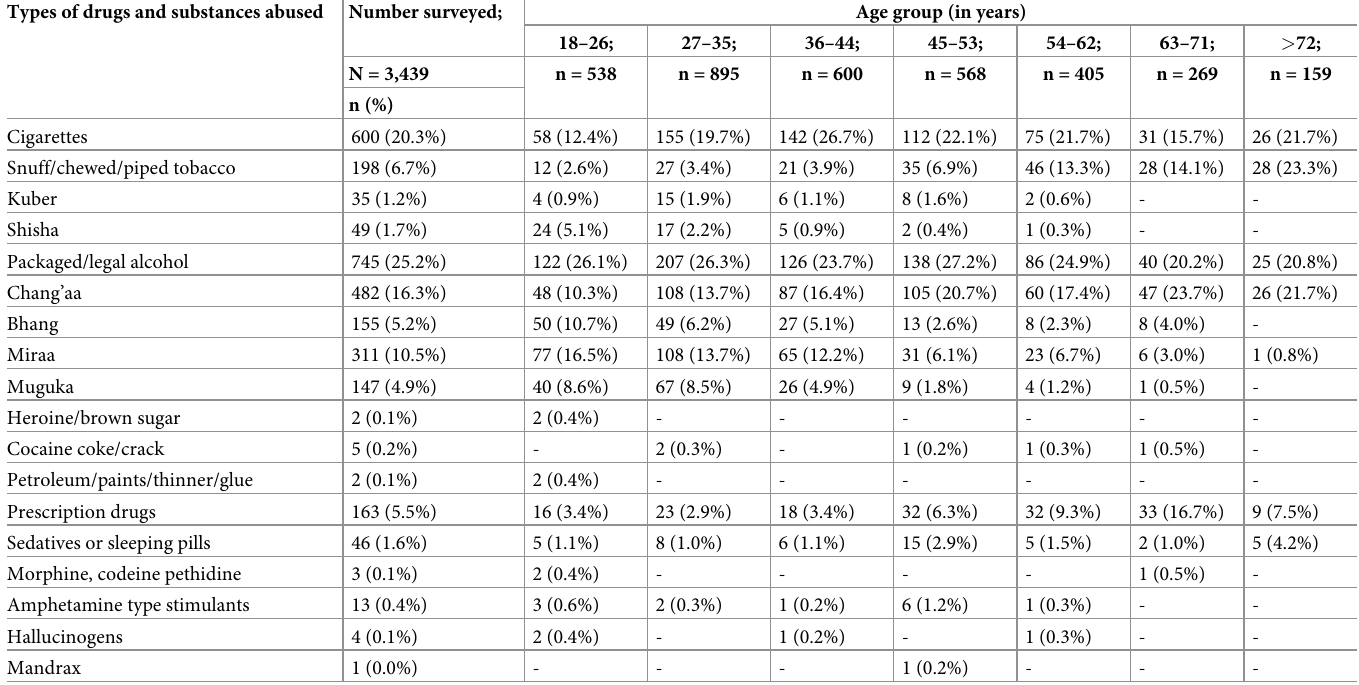
Table 2. Types of drugs and substances abused by respondents according to age group. Types of drugs and substances